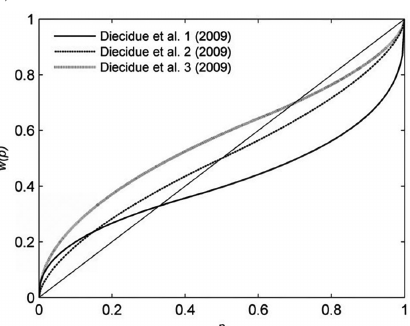
Figure 3. Two-Parameter PWF models were es- Figure 2. One-Parameter PWF models were tablished by Tversky and Fox (1995) by using established by Tversky and Kahneman (1992), Camerer and Ho (1994) and Wu and Gonzalez (1996) using  with taking different parameter values b = 0.61, 0.56, 0.71, and Prelec (1998) using with a = 0.65